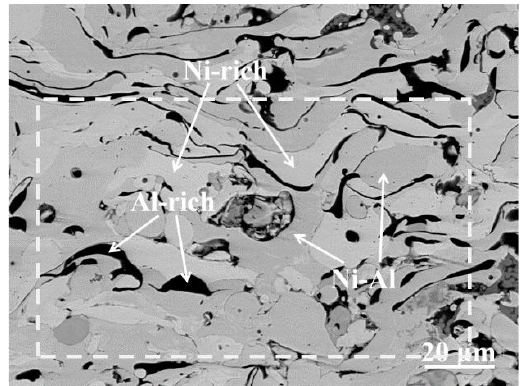
( a ) Backscattering picture for Figure 4f. Figure 6.